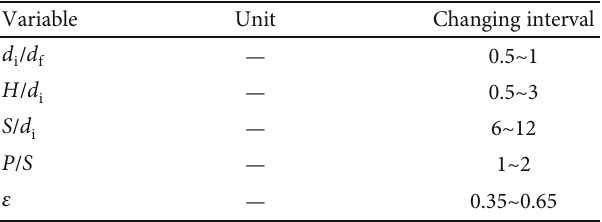
Table 1: Changing interval of geometric parameters in the present